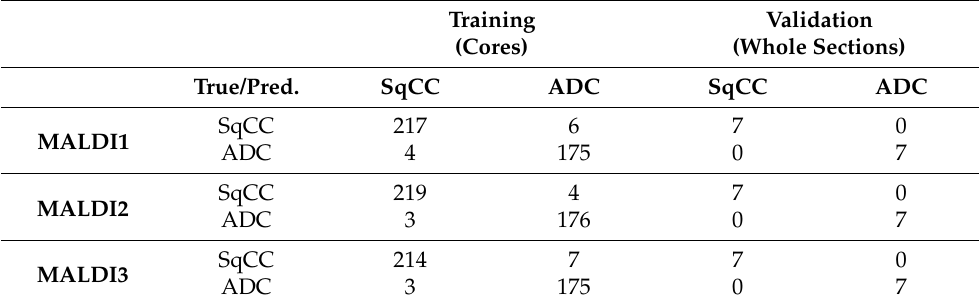
Table A3. Confusion matrices of classification with different MALDI networks on the core/whole section level, on the respective training and validation dataset (Pred. = Prediction). Section/core- wise classification based on the majority vote ( p = 0.5 ). Diagonal elements of the matrices show the number of correctly classified cores/sections, off-diagonal elements show number of misclassified cores/whole sections.